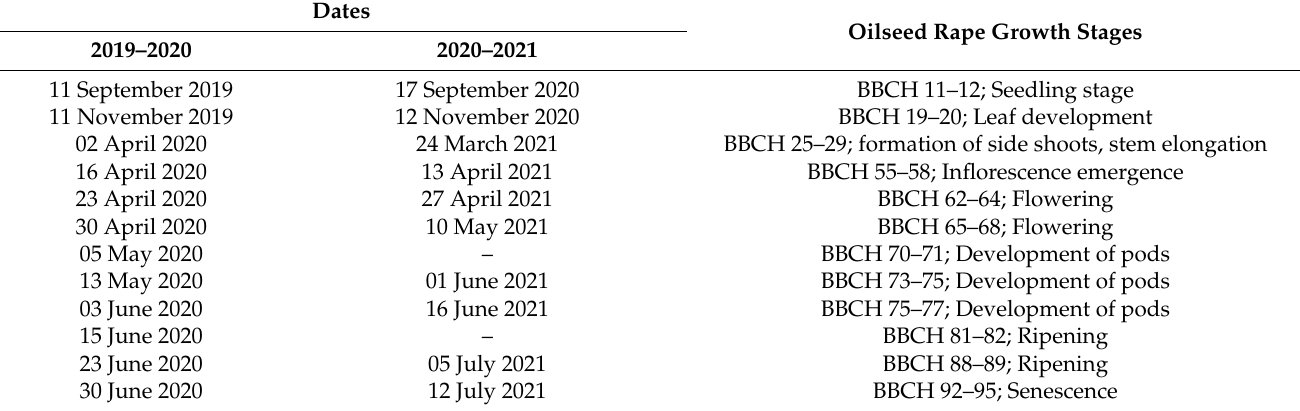
Table 1. Flight dates and different growing stages of winter oilseed rape during the growing seasons